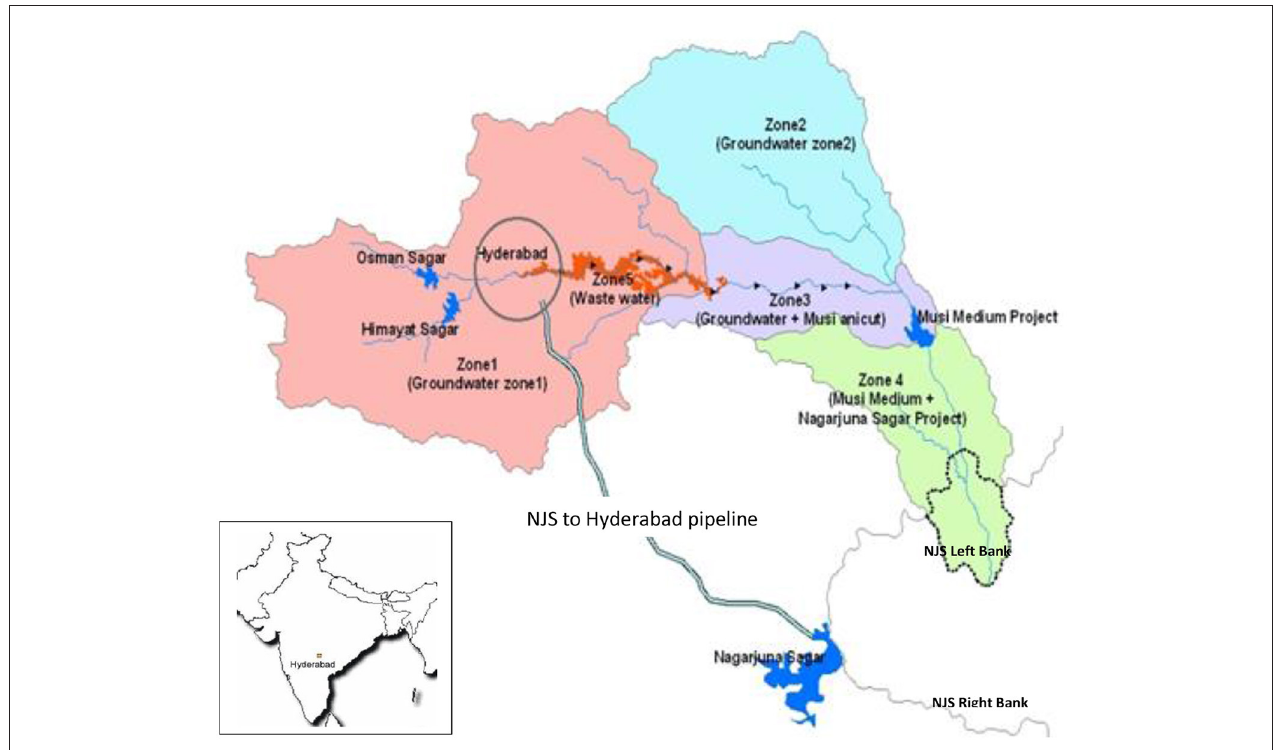
FIGURE 1 | The Musi catchment, India. Source: Adapted from George et al. (2011b).